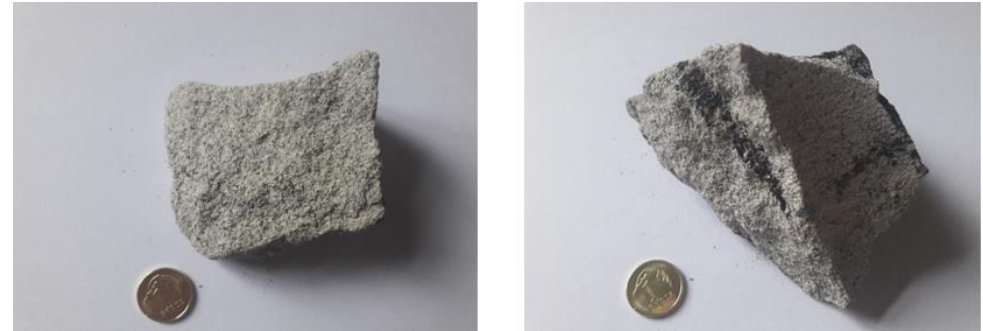
Figure 6. Examples of tested Carboniferous